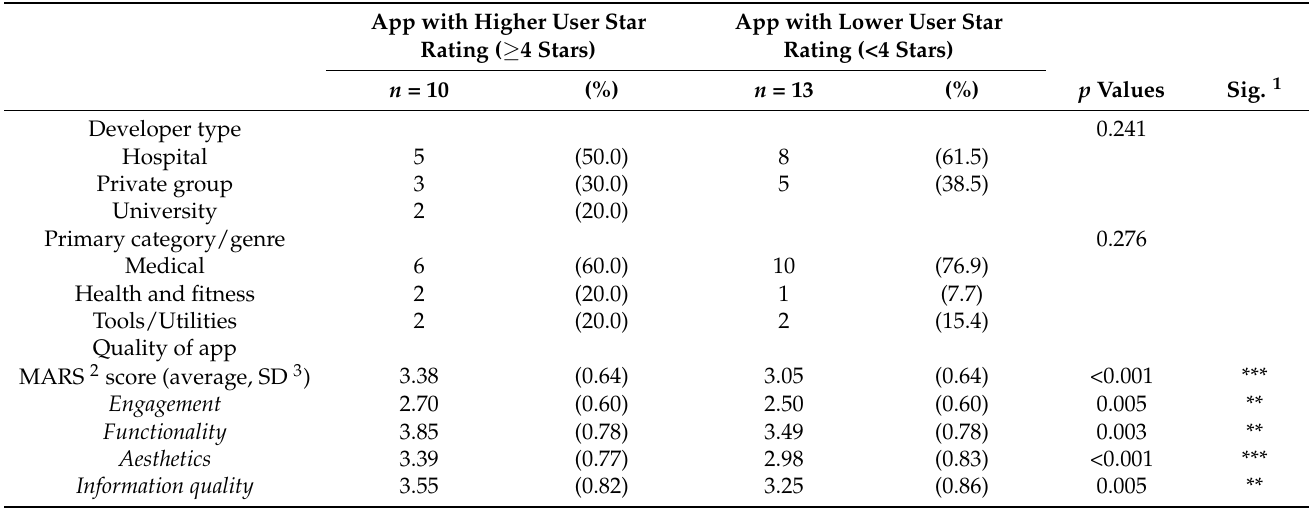
Table 2. Characteristics and Mobile App Rating Scale (MARS) scores of drug reference app stratified by user star ratings. ( n = 23, Taiwan, 2021).